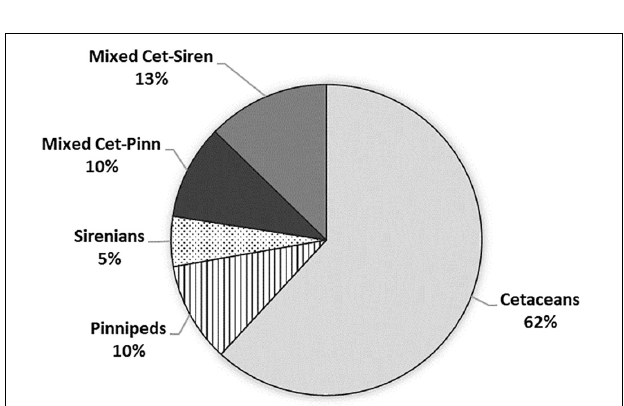
FIGURE 3 | Number of IMMAs defined on the basis of cetaceans, sirenians, or pinnipeds as qualifying marine mammal species, or the mixed presence of cetaceans and pinnipeds (mixed cetaceans/pinnipeds) or cetaceans and sirenians (mixed